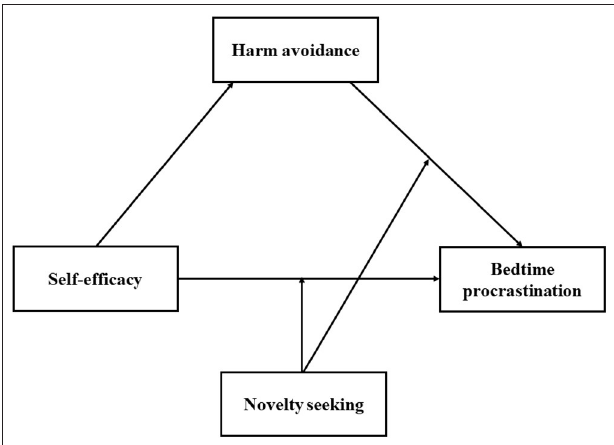
FIGURE 1 | Hypothesized moderated mediation model to predict bedtime